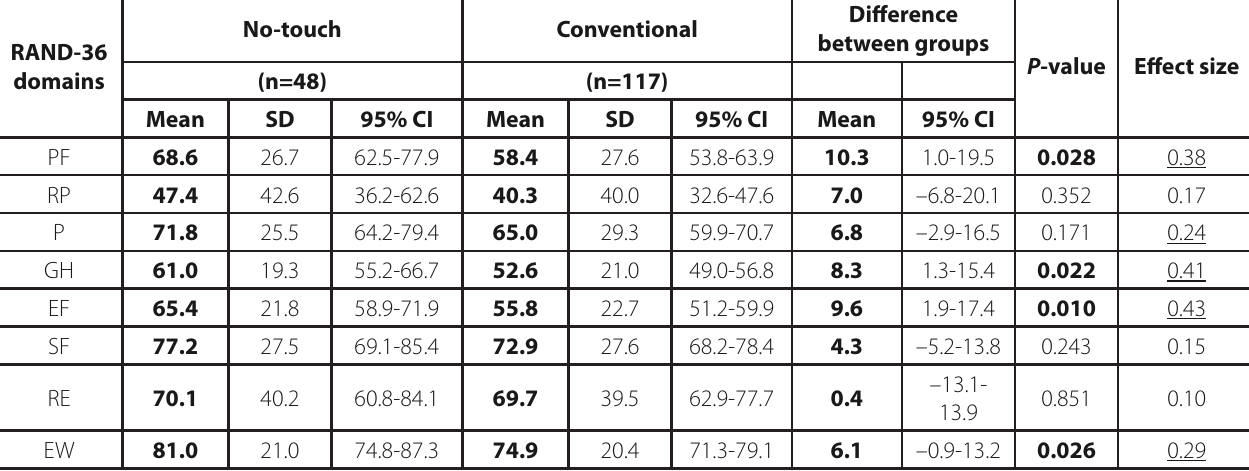
Difference between groups P -value Effect size